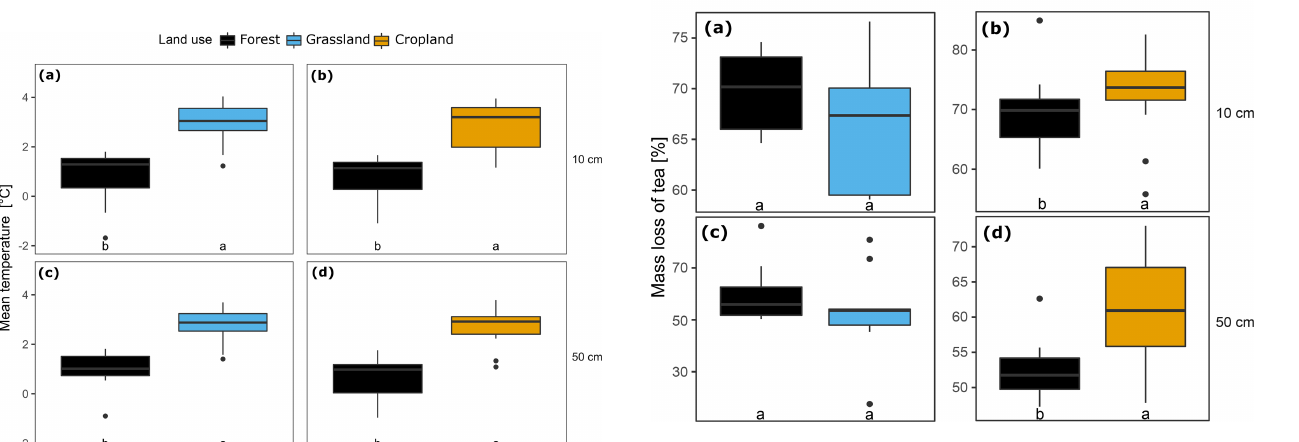
Figure 5. Tukey-style boxplot, comparing mean decomposition of the buried tea bags in grassland–forest pairs ( n = 9) (a, c) and cropland–forest pairs ( n = 12) (b, d) at 10 (a, b) and 50cm (c, d) depth. Different letters at the bottom of each panel indicate sta- tistically significant differences in mass loss based on estimated marginal means at a level of significance of α = 0 . 05 ( p< 0 . 05). In- teractive effects between land use and depths were not